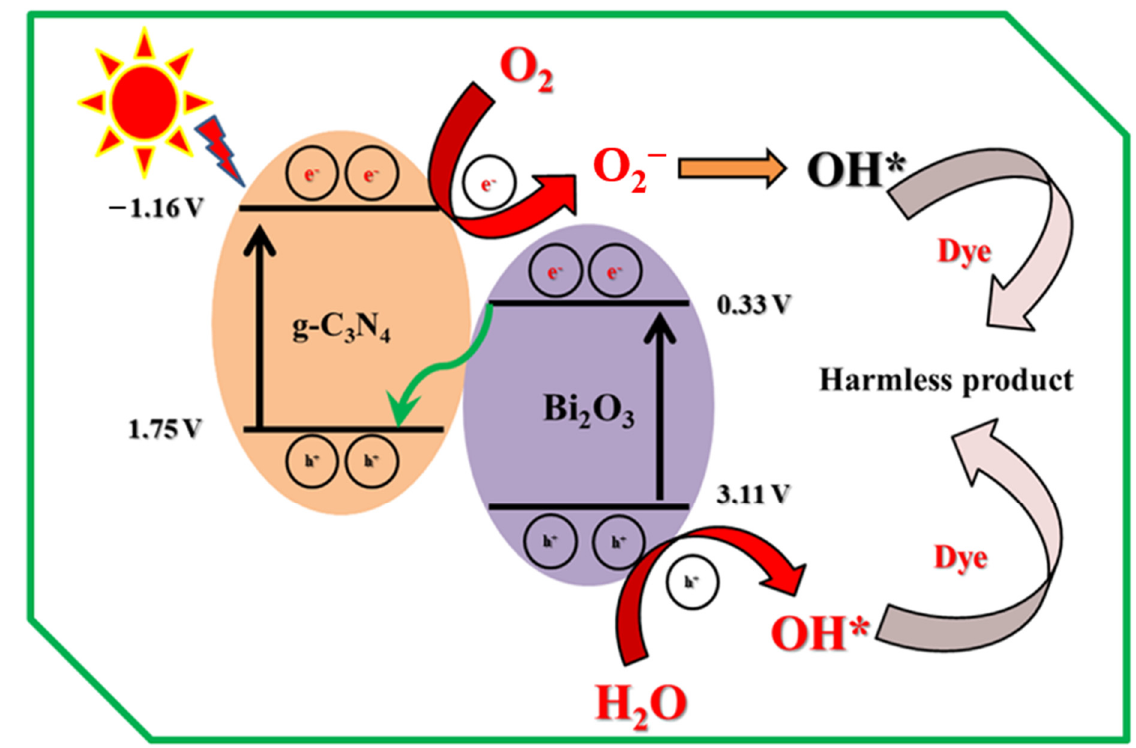
Figure 8. Possible reaction mechanism.